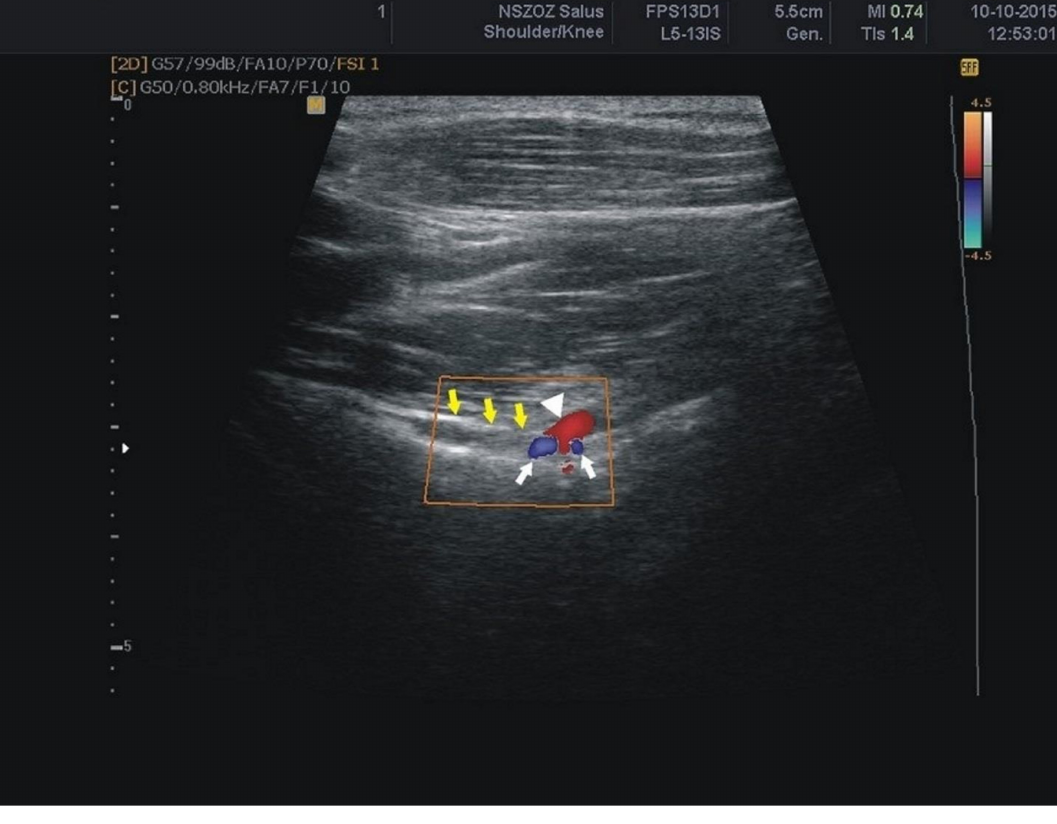
Figure 6. Sonogram of the suprascapular notch region (color Doppler) white arrows: suprascapular veins; arrowhead: suprascapular artery; yellow arrows: superior transverse scapular ligament. Table 2. Visualisation of the suprascapular vein and